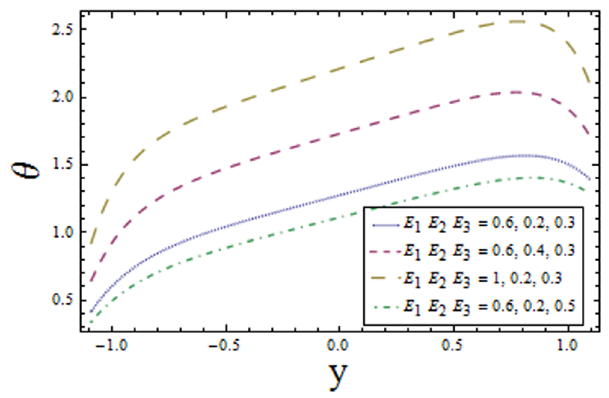
Figure 1. Plot of temperature h for wall parameters E 1 , E 2 , E 3 , with E ~ 0 : 1 , t ~ 0 : 01 , x ~ 0 : 2 , ª 1 ~ 4 , ª 2 ~ 6 , Br ~ 1 ,